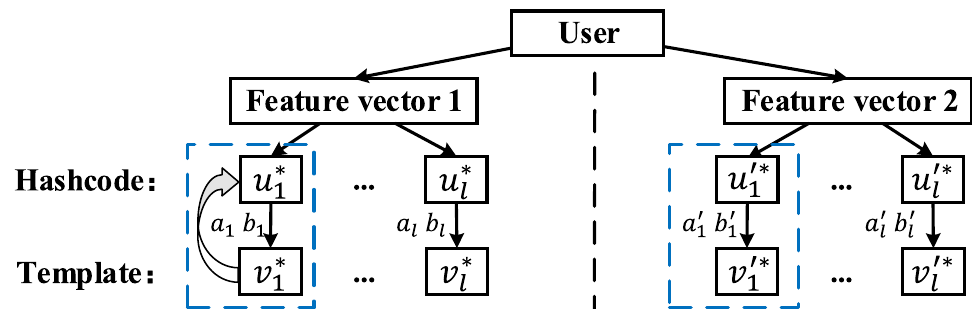
Fig. 10 An explanation of ARM attack to our proposed scheme. The two sides of the black dotted line represent the template generations by same distance-preserving hashing of feature vectors of the same user with different